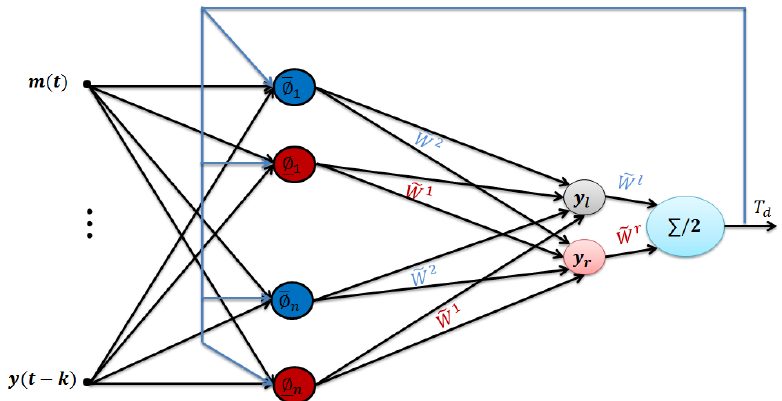
Figure 4. The proposed type 2 fuzzy system.